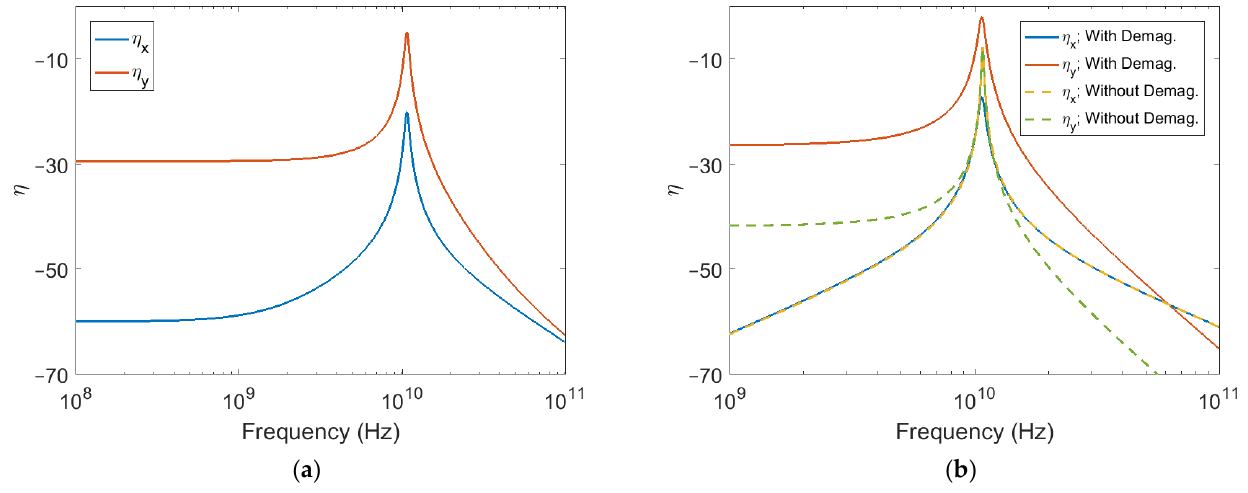
Figure 3. Magnetoelastic coupling coefficient magnitudes under the influence of thin film demagne- tization with ˆ d = ˆ x . ( a ) Coefficients for φ = 45 ◦ ; ( b ) Coefficients for φ = 90 ◦ compared to those of a material with no demagnetization and a bias field H 0 = 3300